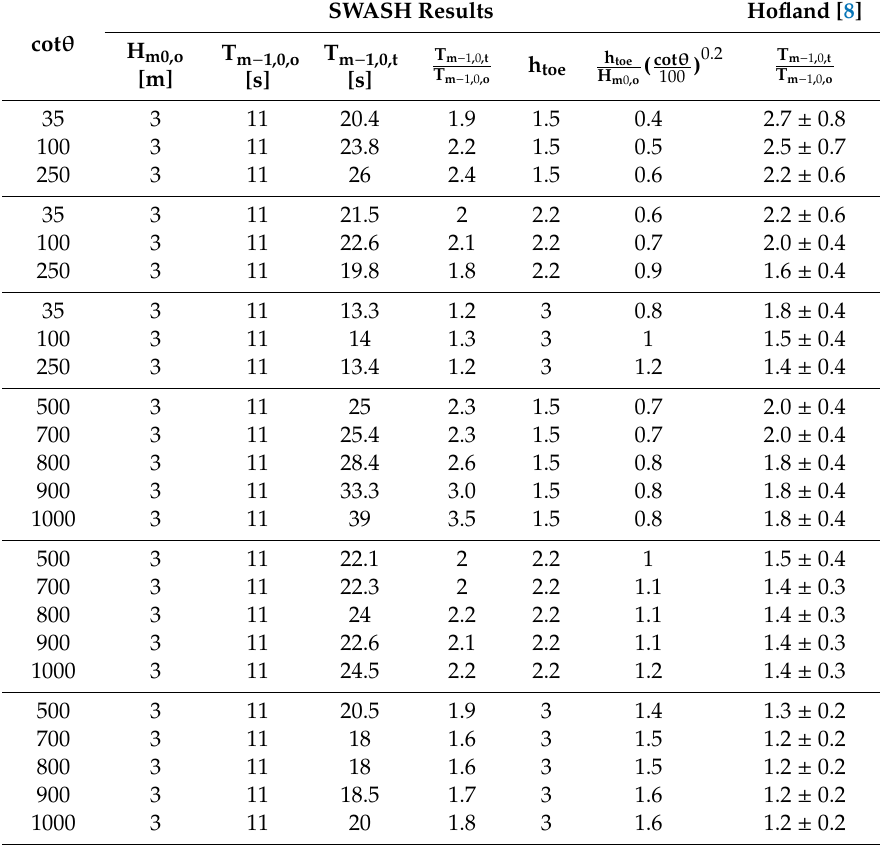
Table 4. A comparison of spectral wave period between Hofland [11] and SWASH results. These are shallow to very shallow conditions according to the Hofland [11] classification, where the ratio T m − 1,0,t from the curve indicates the range ± 2 σ for error